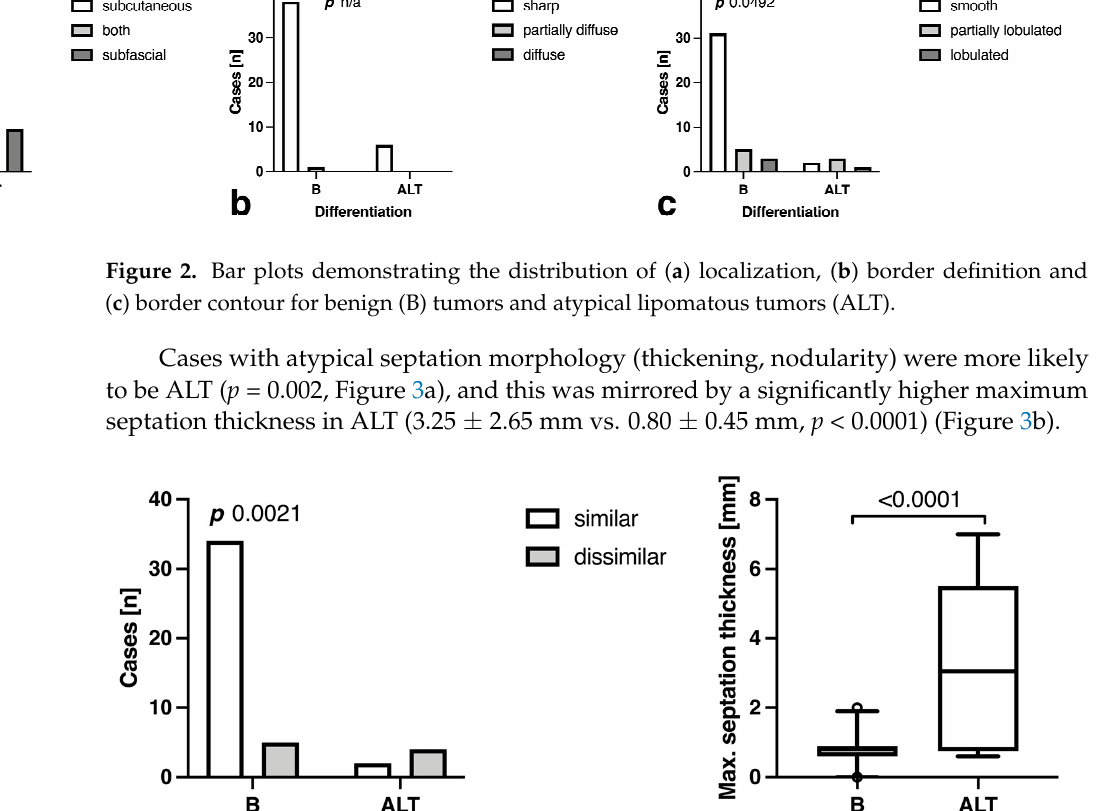
Figure 2. Bar plots demonstrating the distribution of ( a ) localization, ( b ) border definition and ( c ) border contour for benign (B) tumors and atypical lipomatous tumors(ALT).